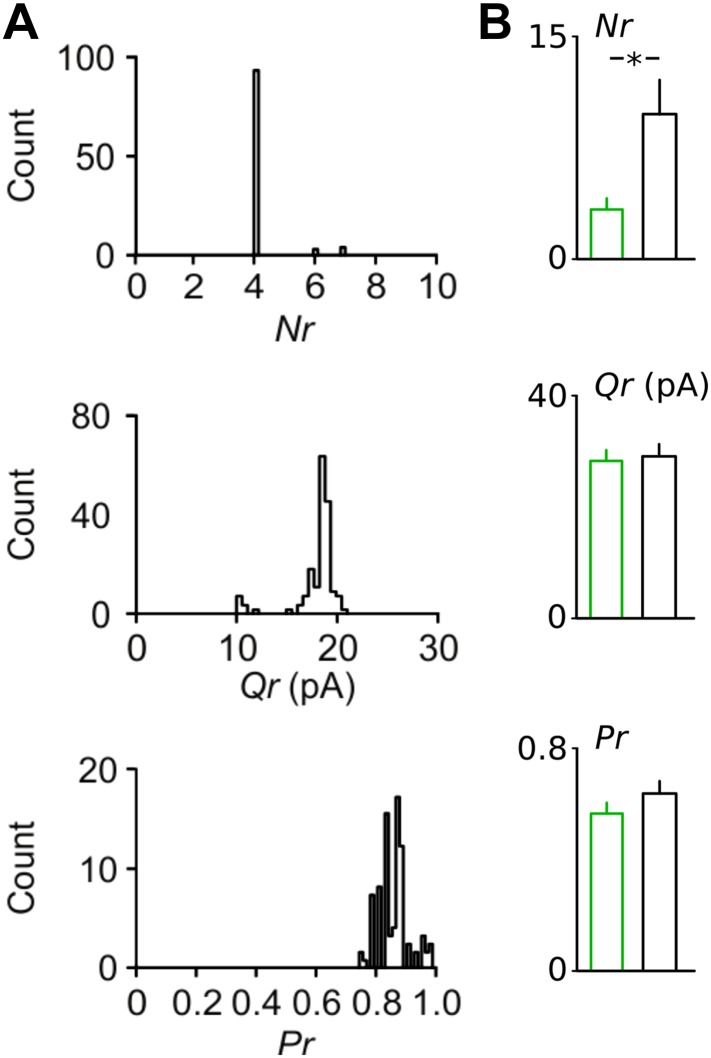
Bootstrapping analysis reveals small errors in the estimation of synaptic parameters with binomial fitting.(A) Examples of bootstrapping of the original data from the Disc1 paired recording shown in Figure 3B. Bootstrap replications (n = 100) of the original data set were fitted in identical manner as the original data shown in Figure 4B,C. (B) Summary graphs of the synaptic parameters Nr, Pr and Qr for bootstrapping results of all pairs revealed a difference in Nr but nor Qr or Pr. Note the small errors in the estimate of all three parameters obtained. Bars represent mean ± SEM. *p < 0.05.